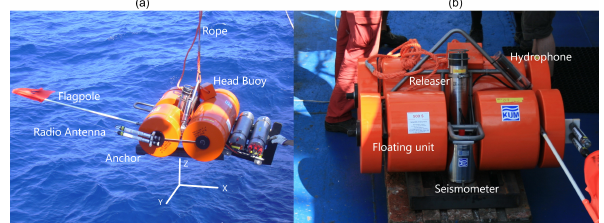
Figure 3. LOBSTER OBS – LOBSTER OBS used in NEAREST project. (a) OBS suspended by the ship’s crane, waiting for the de- ploy signal; (b) on the deck of RV Urania ready to be